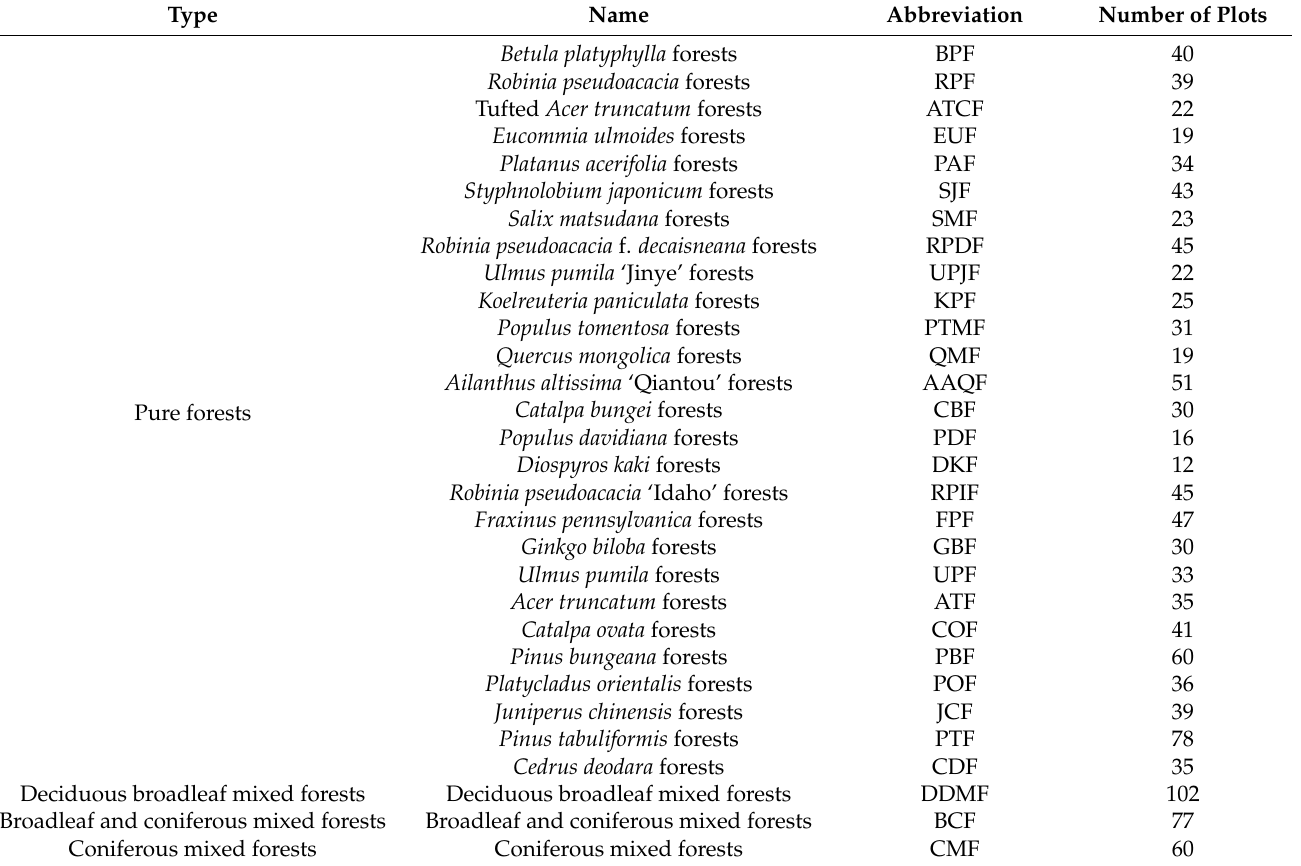
Table 2. Community types of the study sample plots ( n =